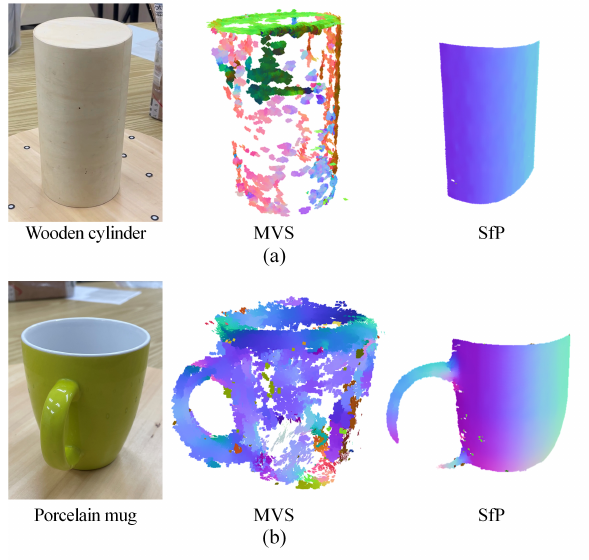
Figure 3. Real-world testing on a wooden cylindrical form object and a porcelain